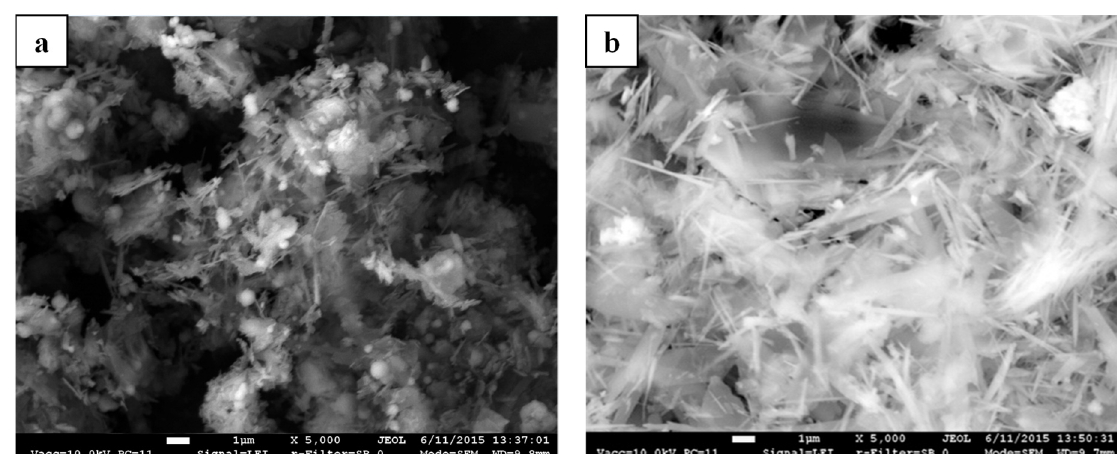
Figure 5. SEM micrograph of synthesis products from lime–GSW ( a ) and lime–opoka ( b ) mixtures with CaO/SiO 2 = 1.0 after 72 h at 200 °C.